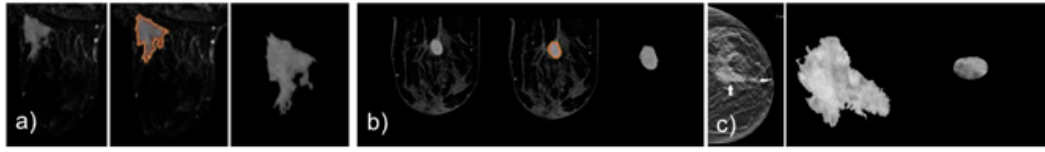
Figure 2. Lesion segmentation and extraction. ( a ) malignant lesion from breast MRI. ( b ) benign lesion from breast MRI. ( c ) malignant lesion from dual energy contrast enhancement mammography